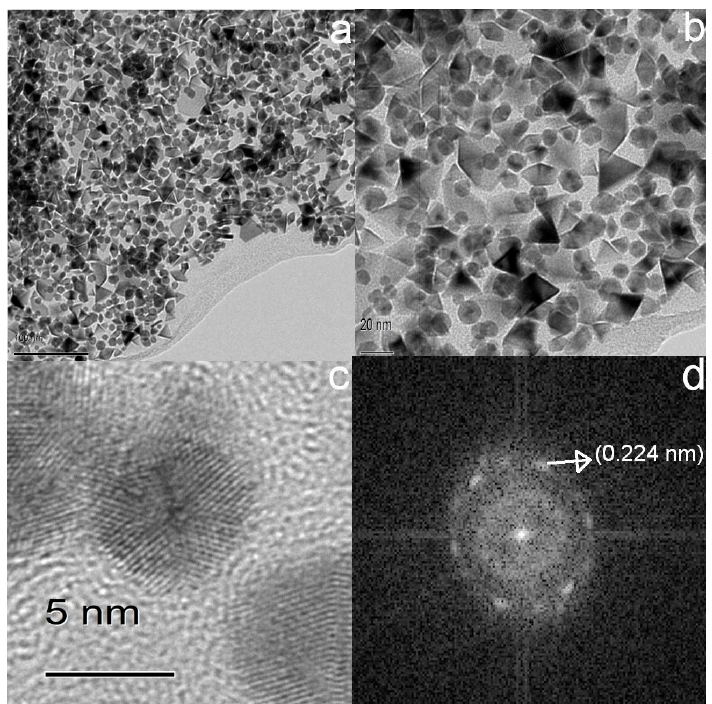
Figure 4. (HR)TEM micrographs of polyhedral and multiply-twinned (mixed shaped m) Pd NPs: overview ( a , b ); HR-TEM ( c ); and FFT pattern ( d ).